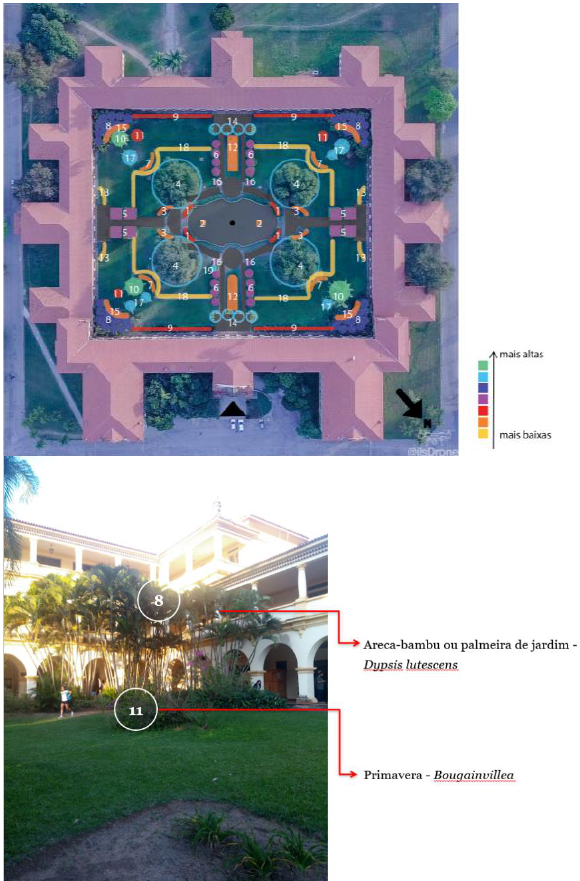
Figure 09. Above: Top view - central garden of the Central Pavilion.